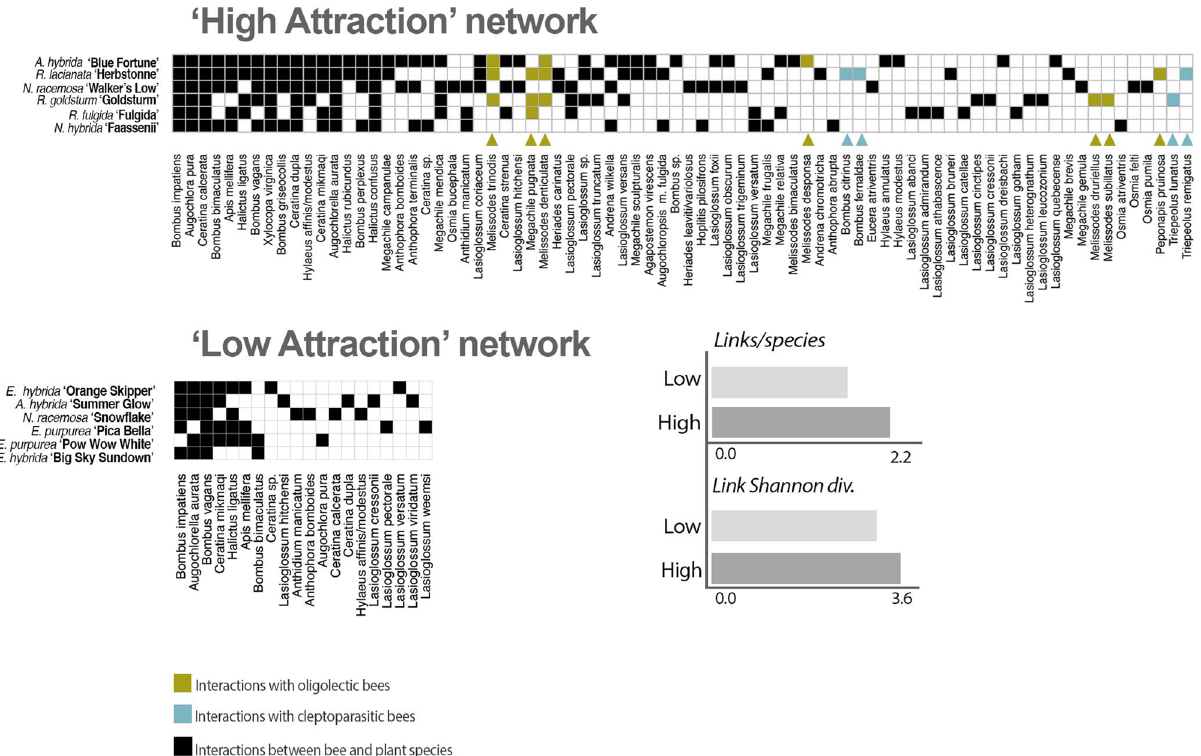
unstable random communities as described in Lever et al. 80